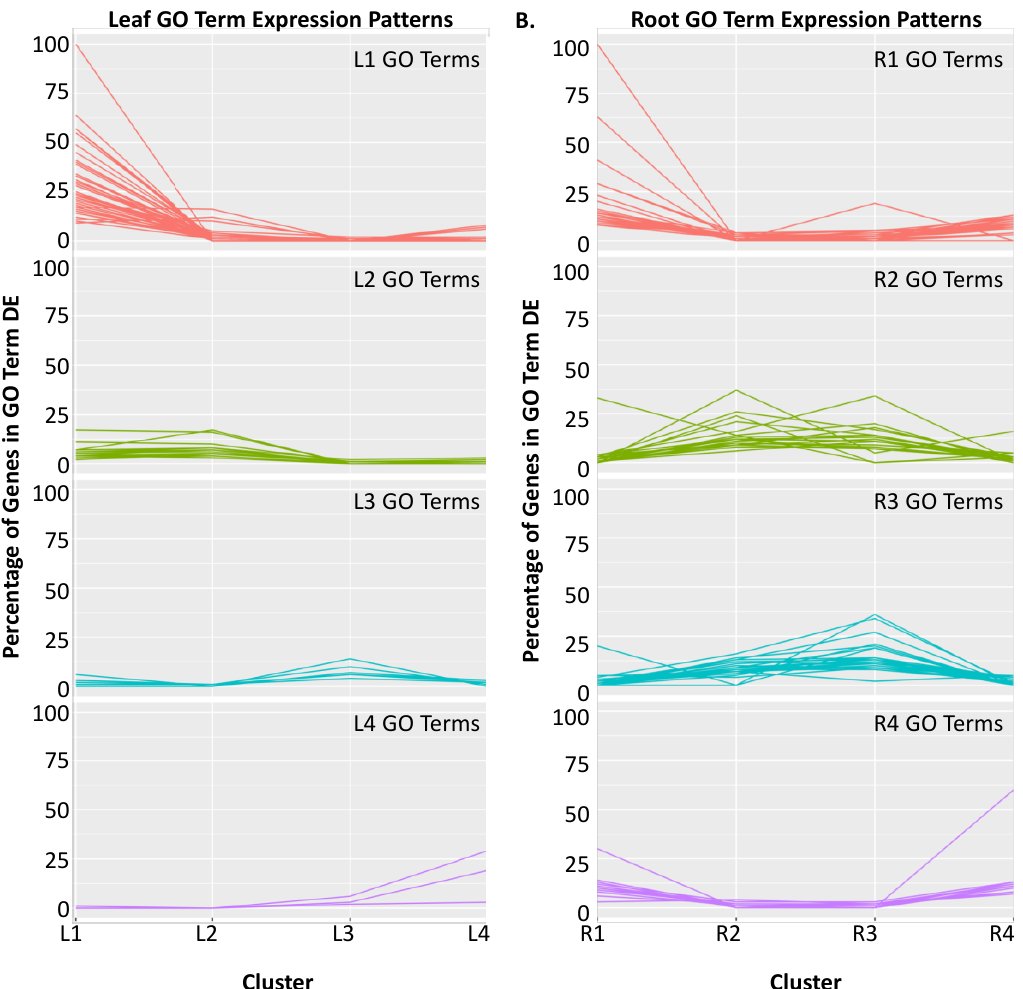
Figure 3. Individual gene expression clusters can be associated with specific biological functions. For